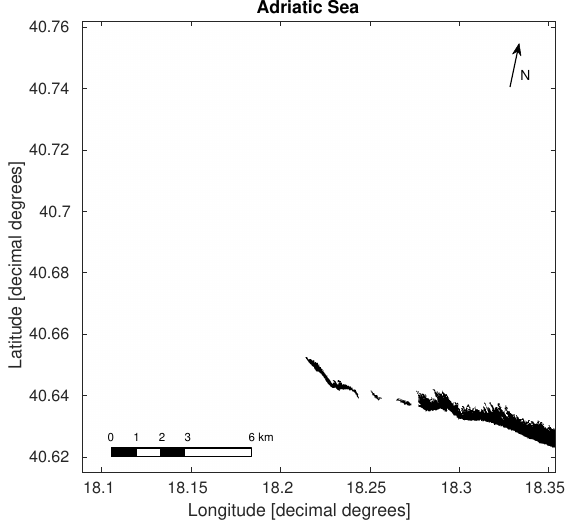
Figure 11. Classification performed on the Adriatic Sea dataset segmented